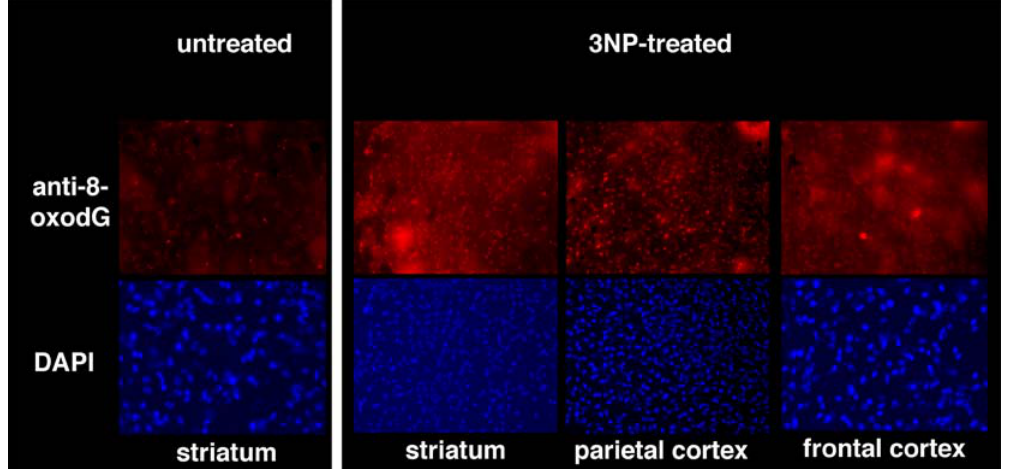
Figure 6. Oxidative DNA damage in the brain. Brains from wild-type mice that had been treated twice per day for 5 days with 60 mg/kg 3-NP were examined for DNA 8-oxodG by immunohistochemistry. Nuclei of striatum, parietal and frontal cortex were counterstained by